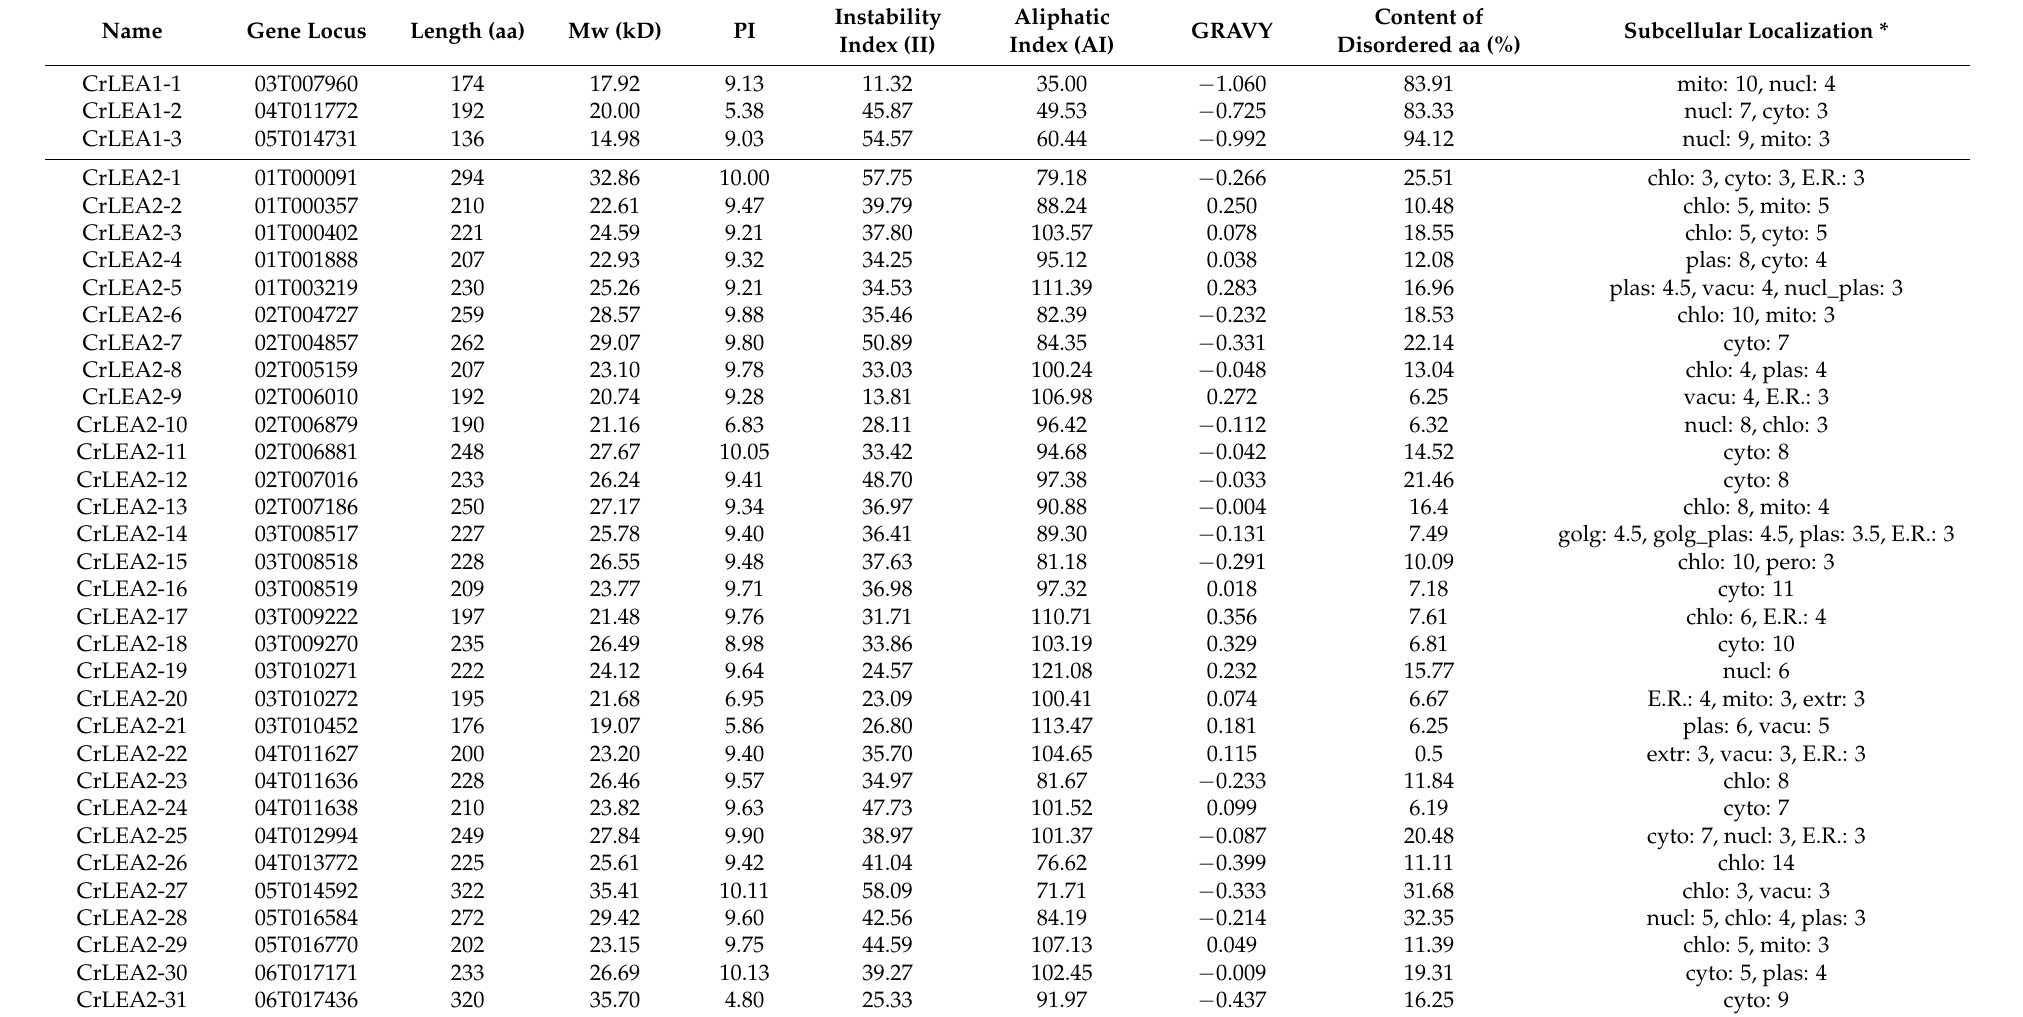
Table 1. Description of CrLEAs identified from Canavalia rosea